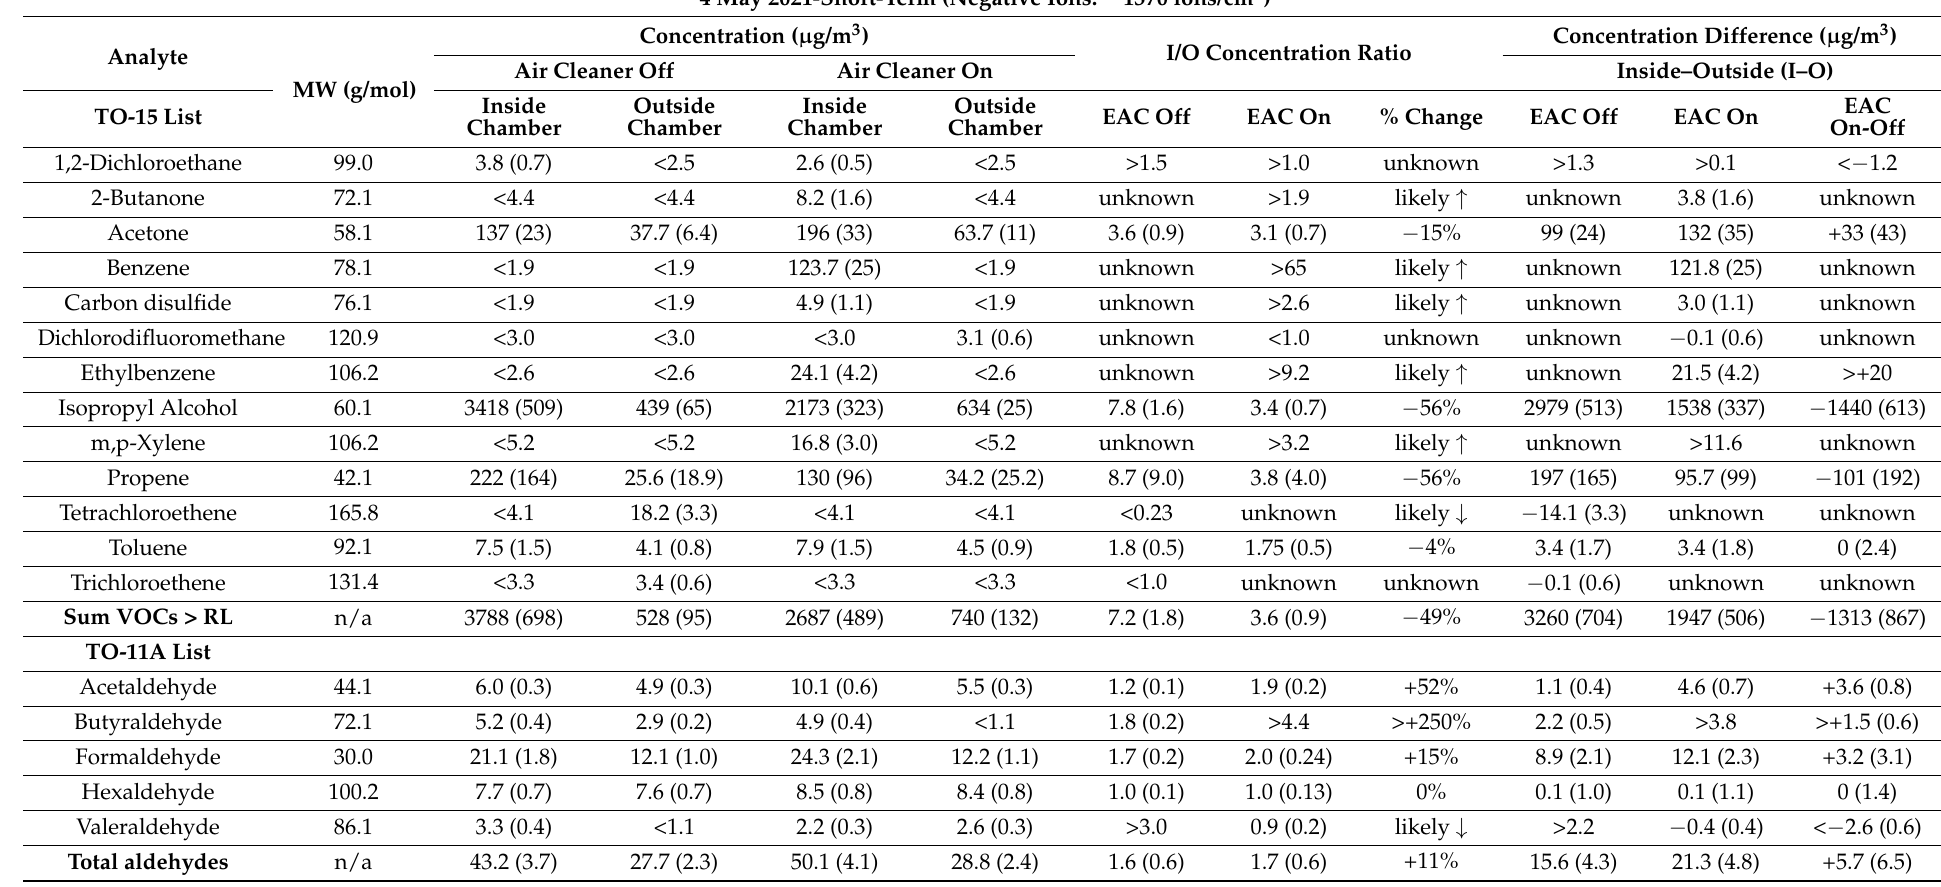
Table A1. Resulting concentrations and calculated inside/outside (I/O) chamber concentration ratios for TO-15/TO-11A analytes above reporting limits (RL) in at least one air sample from the 4 May 2021 short-term natural condition test. Symbols “likely ↑ ” and “likely ↓ ” denote likely, albeit not directly quantifiable, increases and decrease,